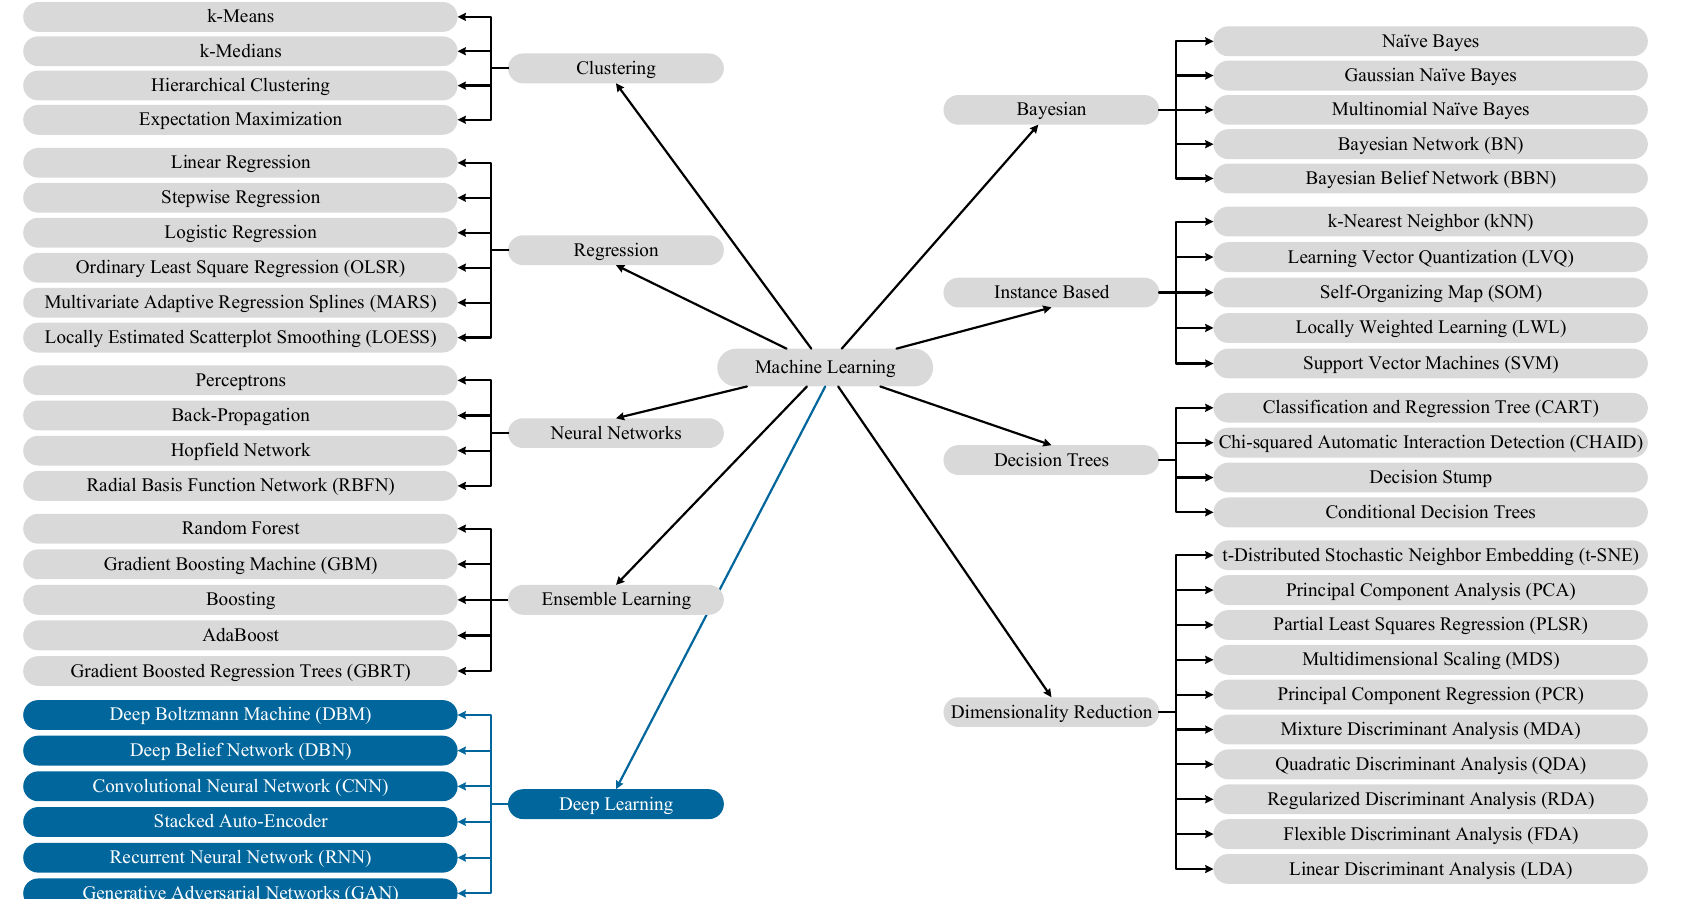
Figure 2. Machine Learning (ML) algorithms mind map.